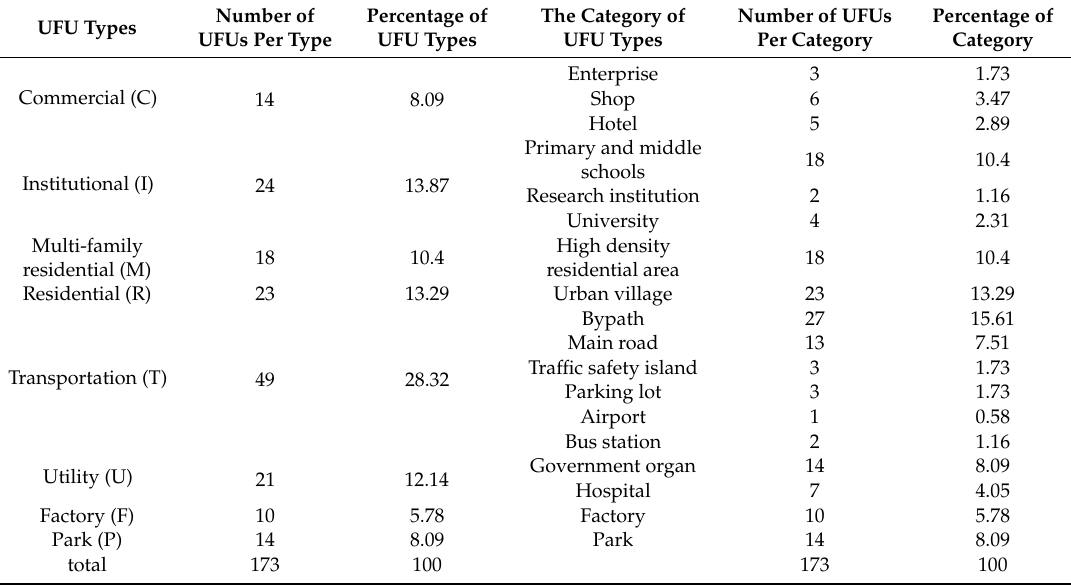
Table 4. The number of Urban Functional Unit (UFU) types and their